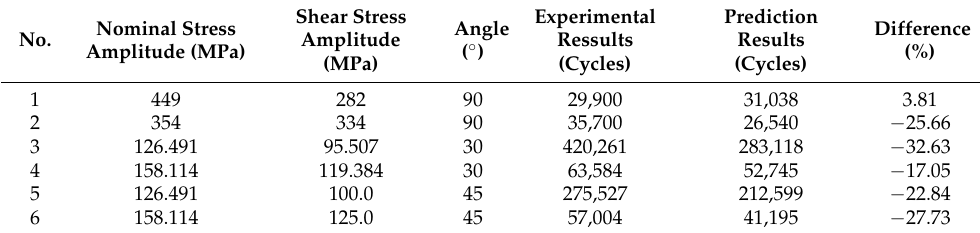
Table 2. Validation of the applied critical plane approach